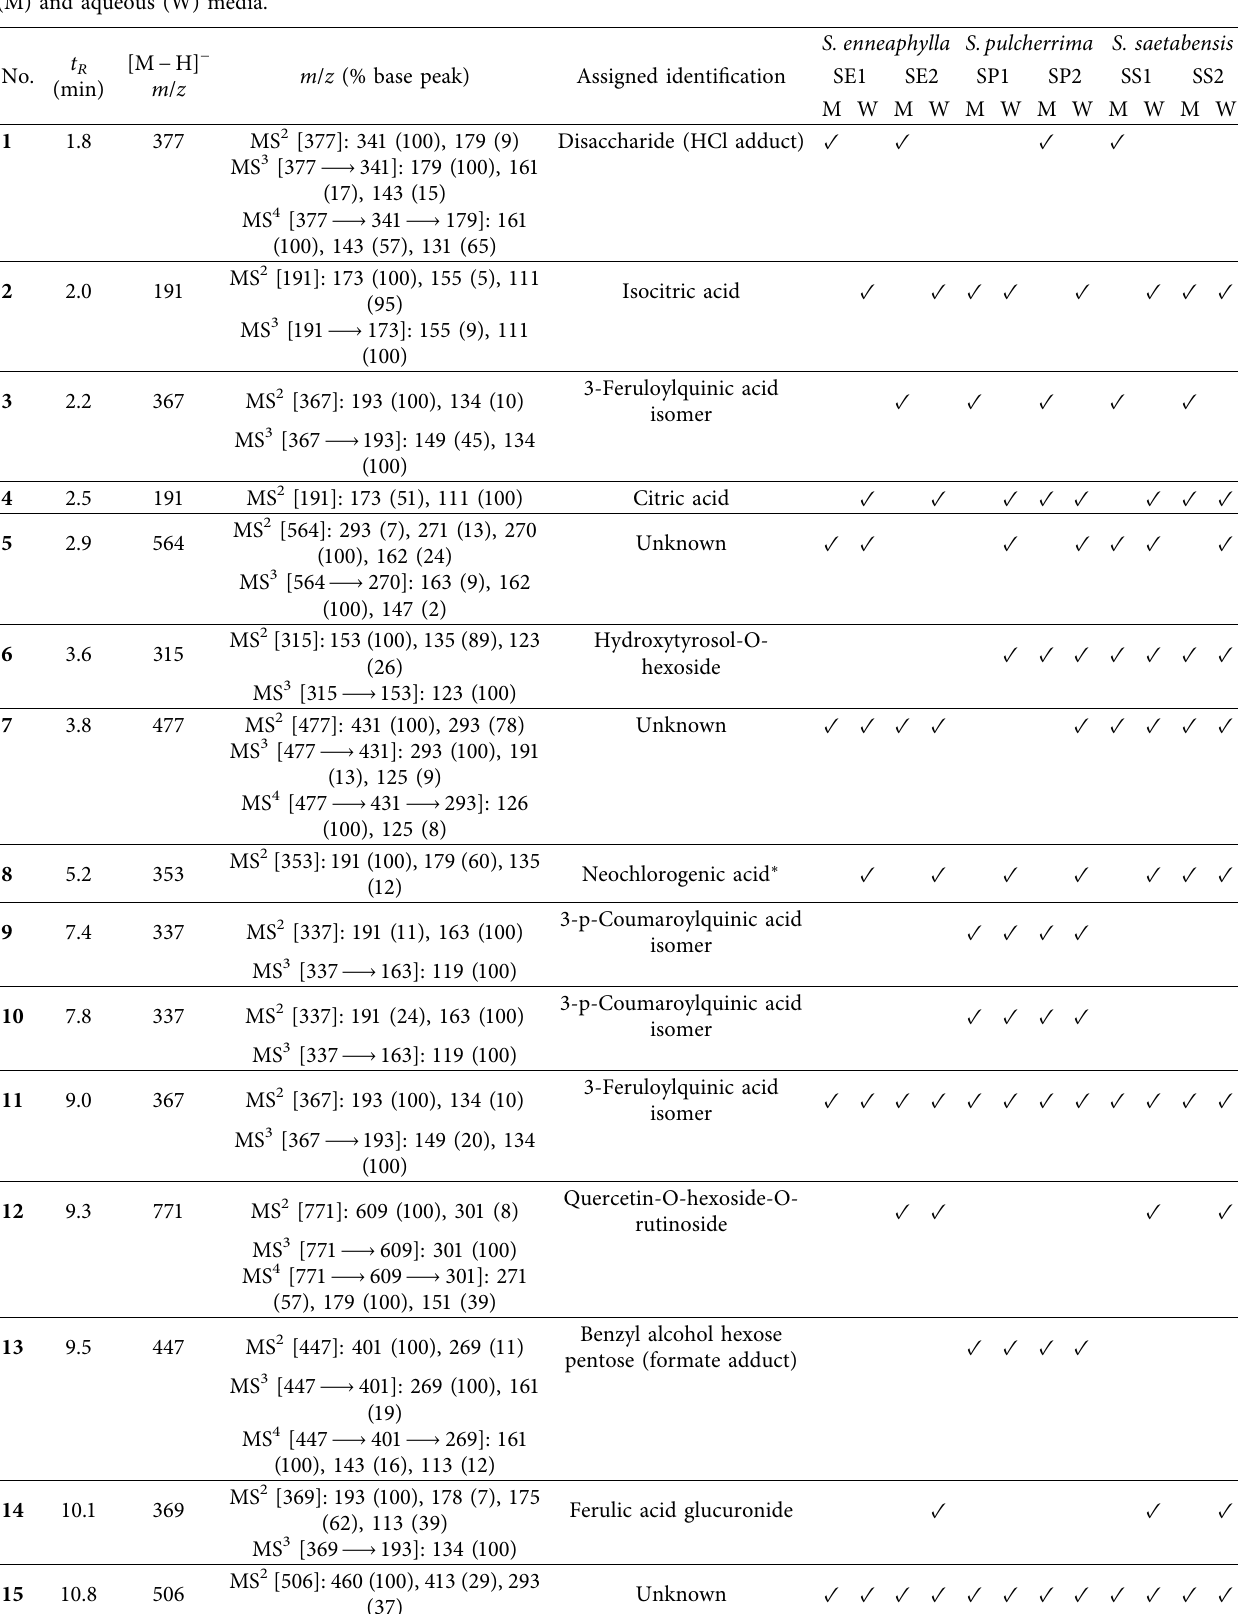
Table 2: Characterization of the compounds found in the analyzed extracts of Sarcocapnos species by HPLC-DAD/ESI-MS n , in methanolic (M) and aqueous (W) media.